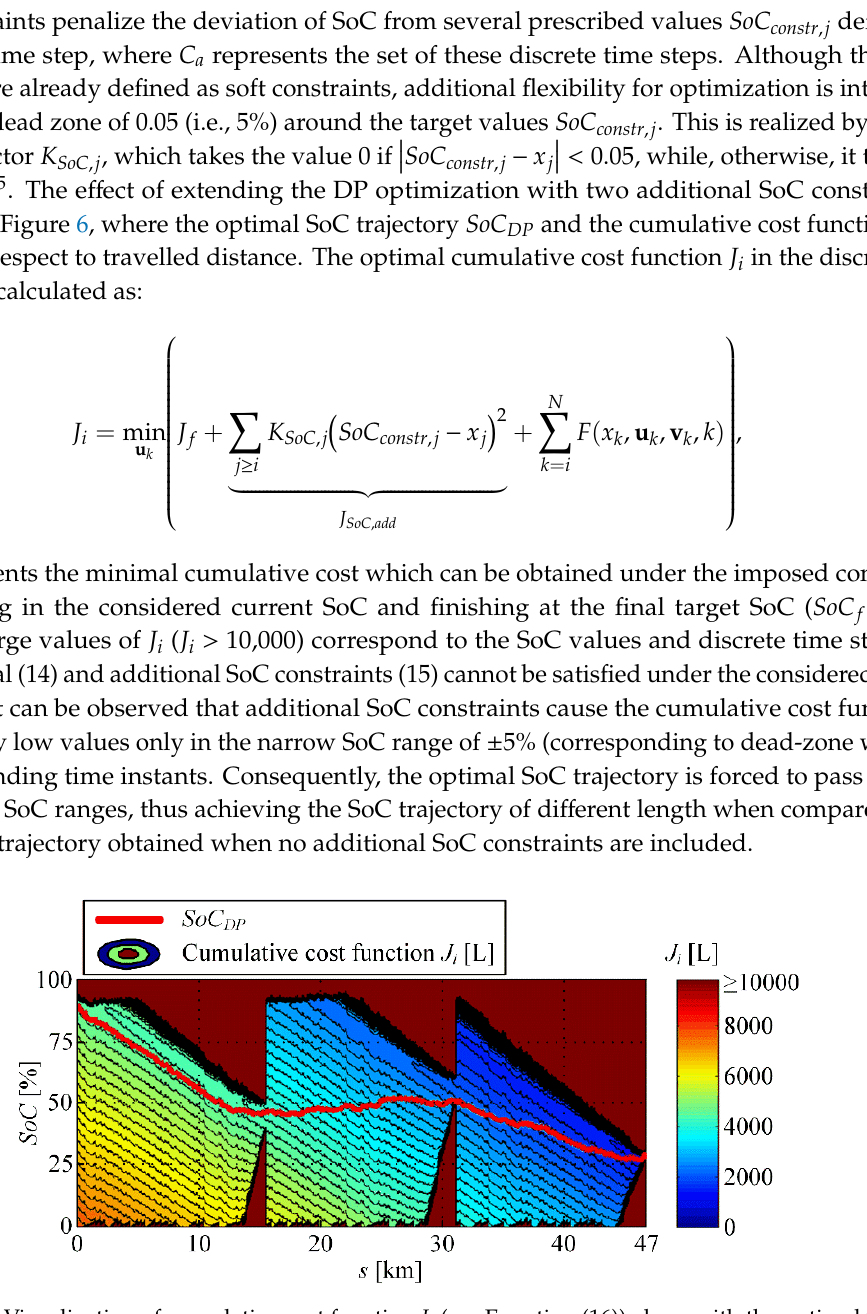
Figure 6. Visualization of cumulative cost function J i (see Equation (16)) along with the optimal SoC trajectory SoC DP for the case of two additional SoC constraints (i.e., SoC constr = 45% at 1 / 3 of total trip distance, and SoC constr = 55% at 2 / 3 of total trip distance) and 4 x DUB driving cycle with a zero road grade.